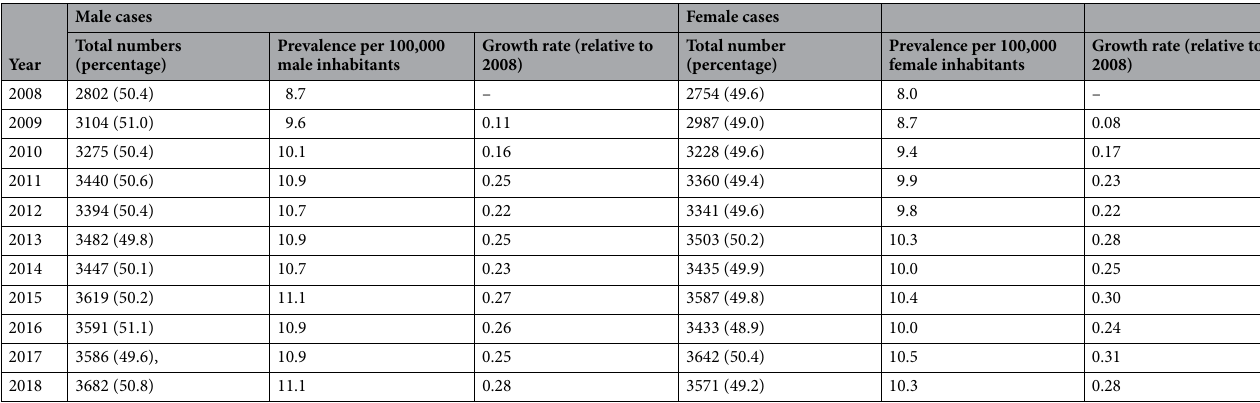
Table 3. Historic development from 2008 through 2018 of all fracture-related infection cases as a function of